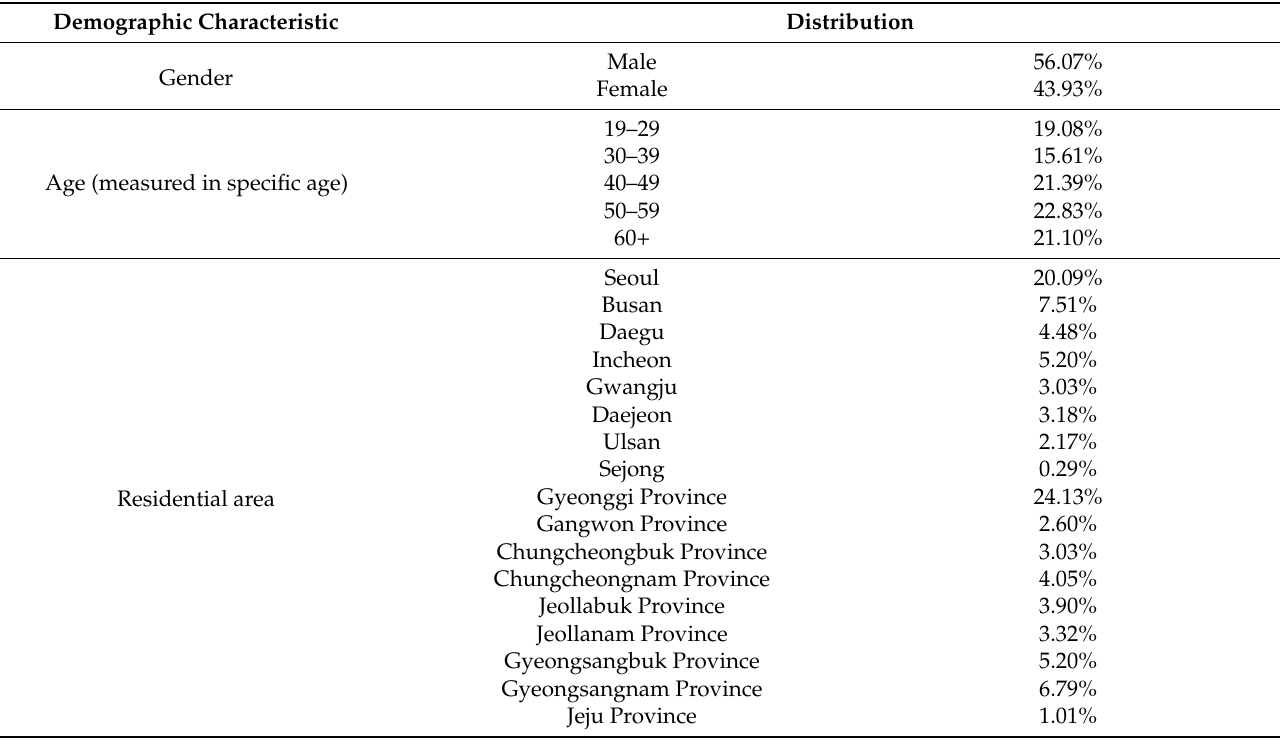
Table 1. Study sample